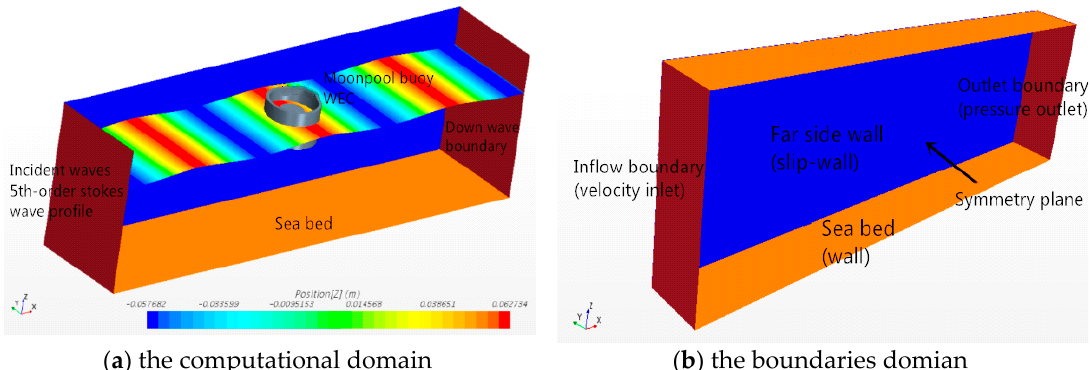
Figure 5. Computational domain and domain boundaries.